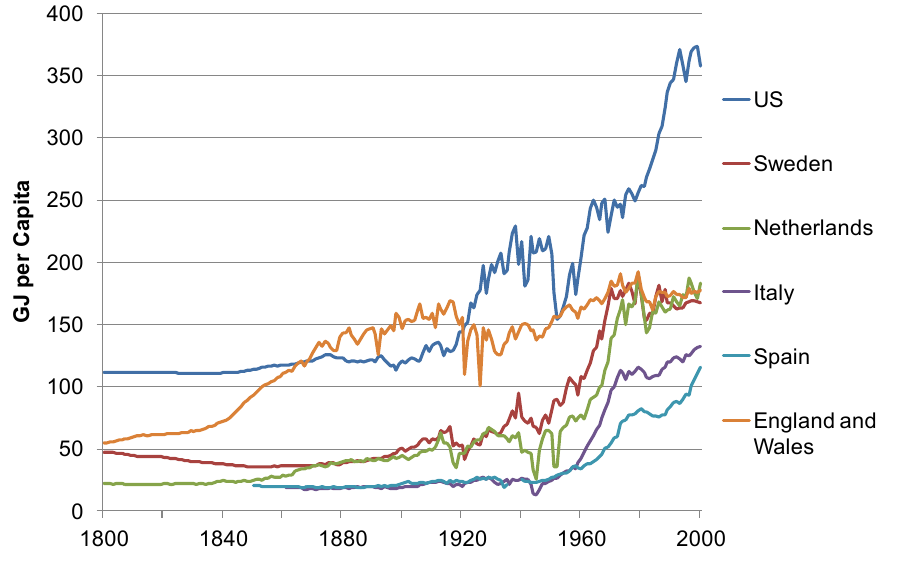
Figure 20. Energy consumption per capita in selected countries, 1800–2000. Sources: [4] for Sweden, The Netherlands, Italy, and Spain; [77] for England and Wales; this analysis for